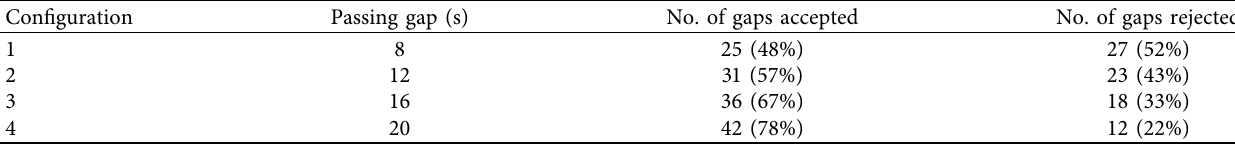
Table 3: Gaps accepted and rejected in the analysis configuration.